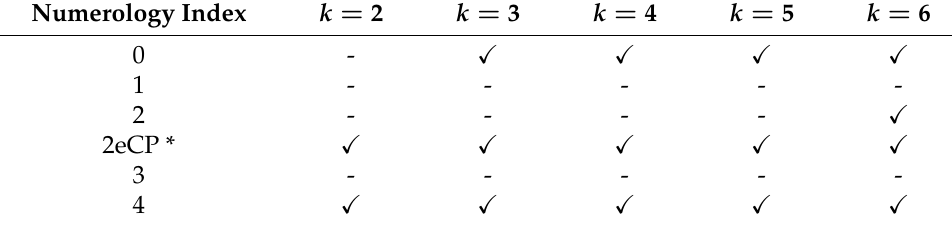
Table 9. Selected numerologies.